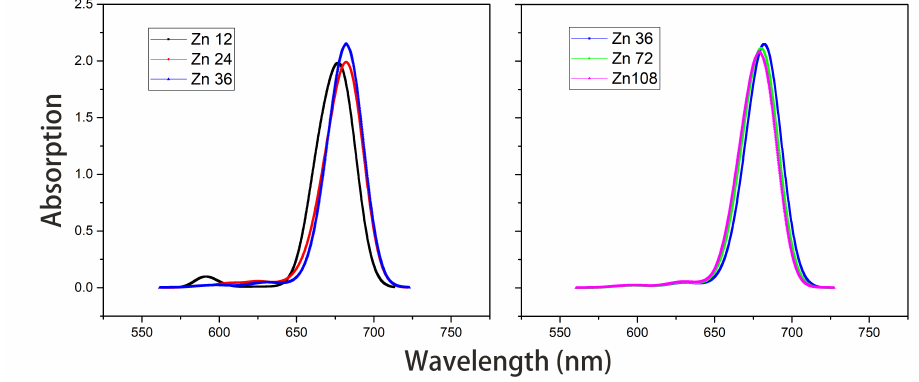
Figure 8. Absorption spectra of model Zn12/24/36 and model Zn36/72/108 in